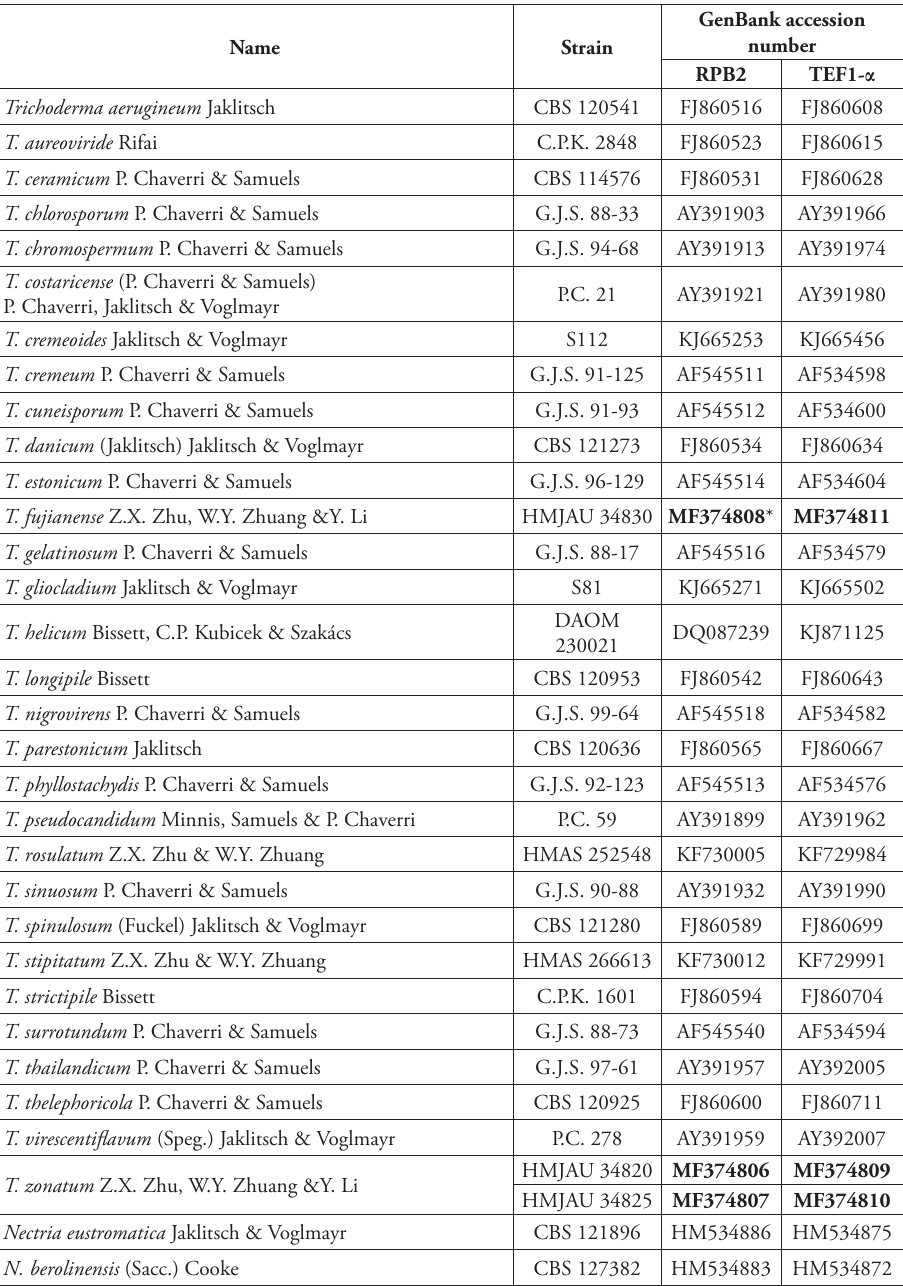
Table 1. Materials including strain numbers and GenBank accessions of sequences used for phylogenetic